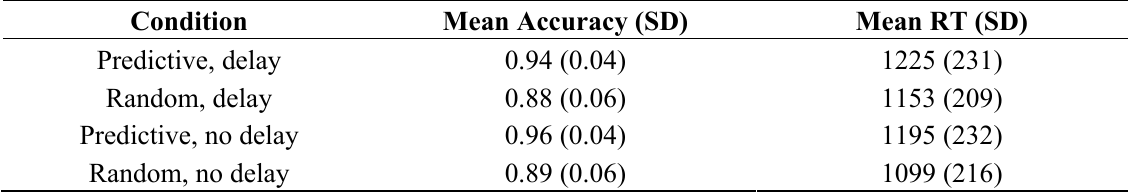
Table 1. Mean proportion of accurate responses and mean response times (RT) in ms to accurate responses in the letter recognition task (standard deviation in